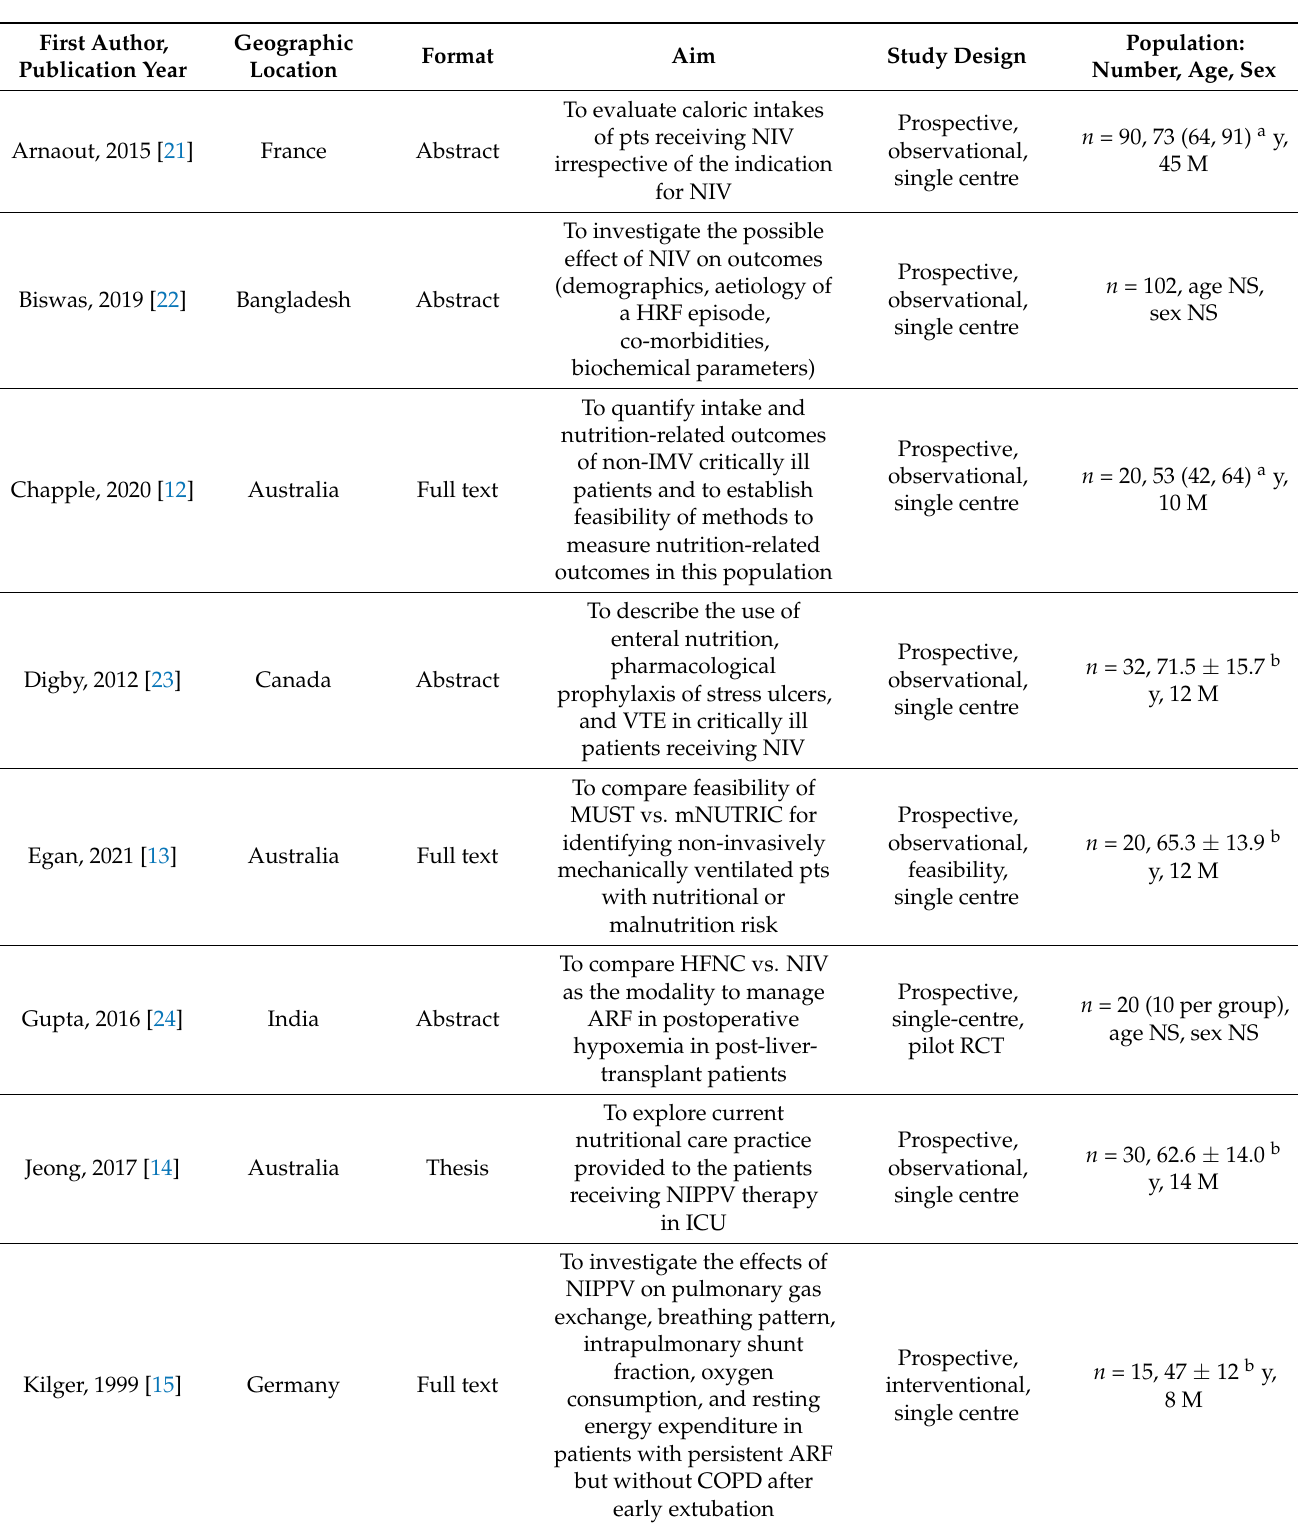
Table 2. Aim, study design, and population of included